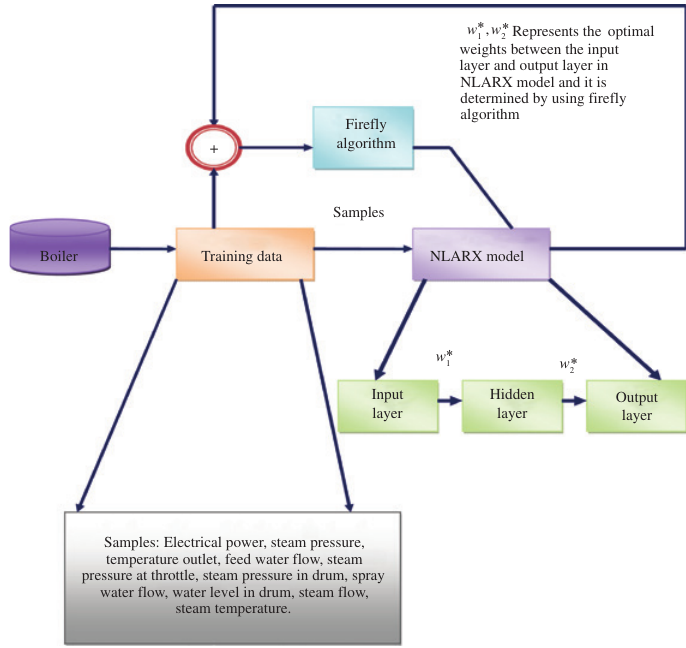
Figure 3: NLARX Learning by FF Algorithm for Modeling of Boiler